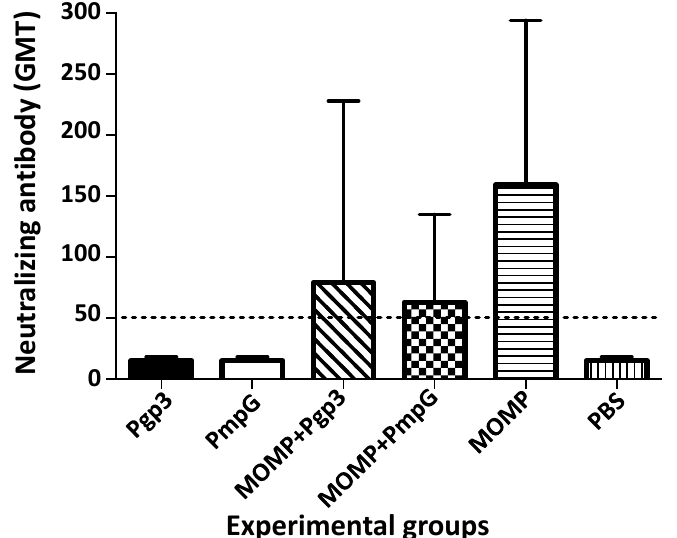
Figure 5. Vaccine elicited levels of neutralizing antibody (GMT ± SE) in sera the day before the C. muridarum i. n. challenge. Serum samples were incubated with C. muridarum live EBs and the neutralization titer was determined by the dilution of the sera that decreased the number of C. muridarum IFU by 50% compared with the PBS immunized group. BLD (horizontal broken line) < 50.